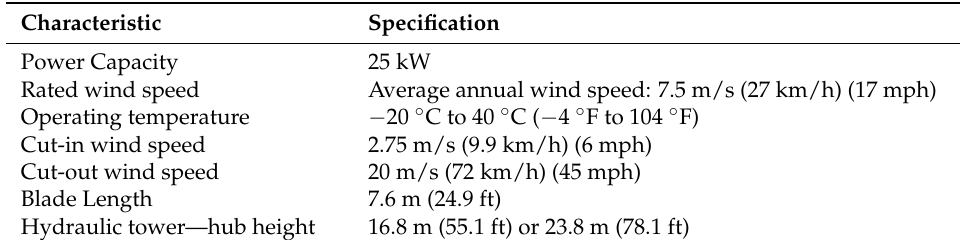
Table 1. The technical specifications of the selected wind turbine.